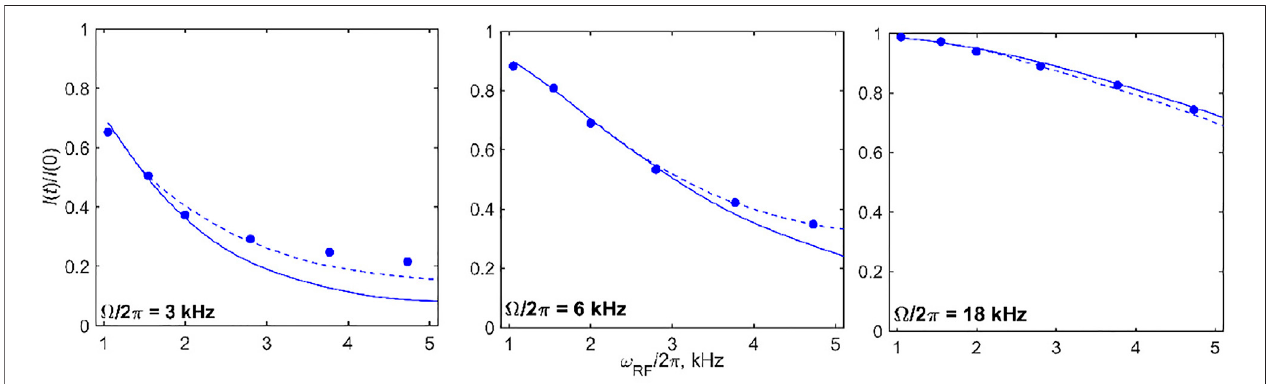
FIGURE 10 | 2 H CEST DMS central band intensities I ( t )/ I (0) for selected values ofoffsets (shown directly on the panels) as a function of ω RF / 2 π for T (cid:2) 20 ms at the 60 kHzMASrateandat14.1Tand55 ° C.Thesolidlinesrepresentthesimulationsaccordingtothemodelof Figure3A with k fl ip (cid:2) 2,100 s − 1 and k 3 (cid:2) 3.2 · 10 9 s − 1 without the inclusion ofRF inhomogeneity. The dotted lines stand for the same simulations with the inclusion of the RF inhomogeneity pro fi les of Figure 1B . Experimental errors are within the sizes of the symbols and were obtained as standard errors from three repeated